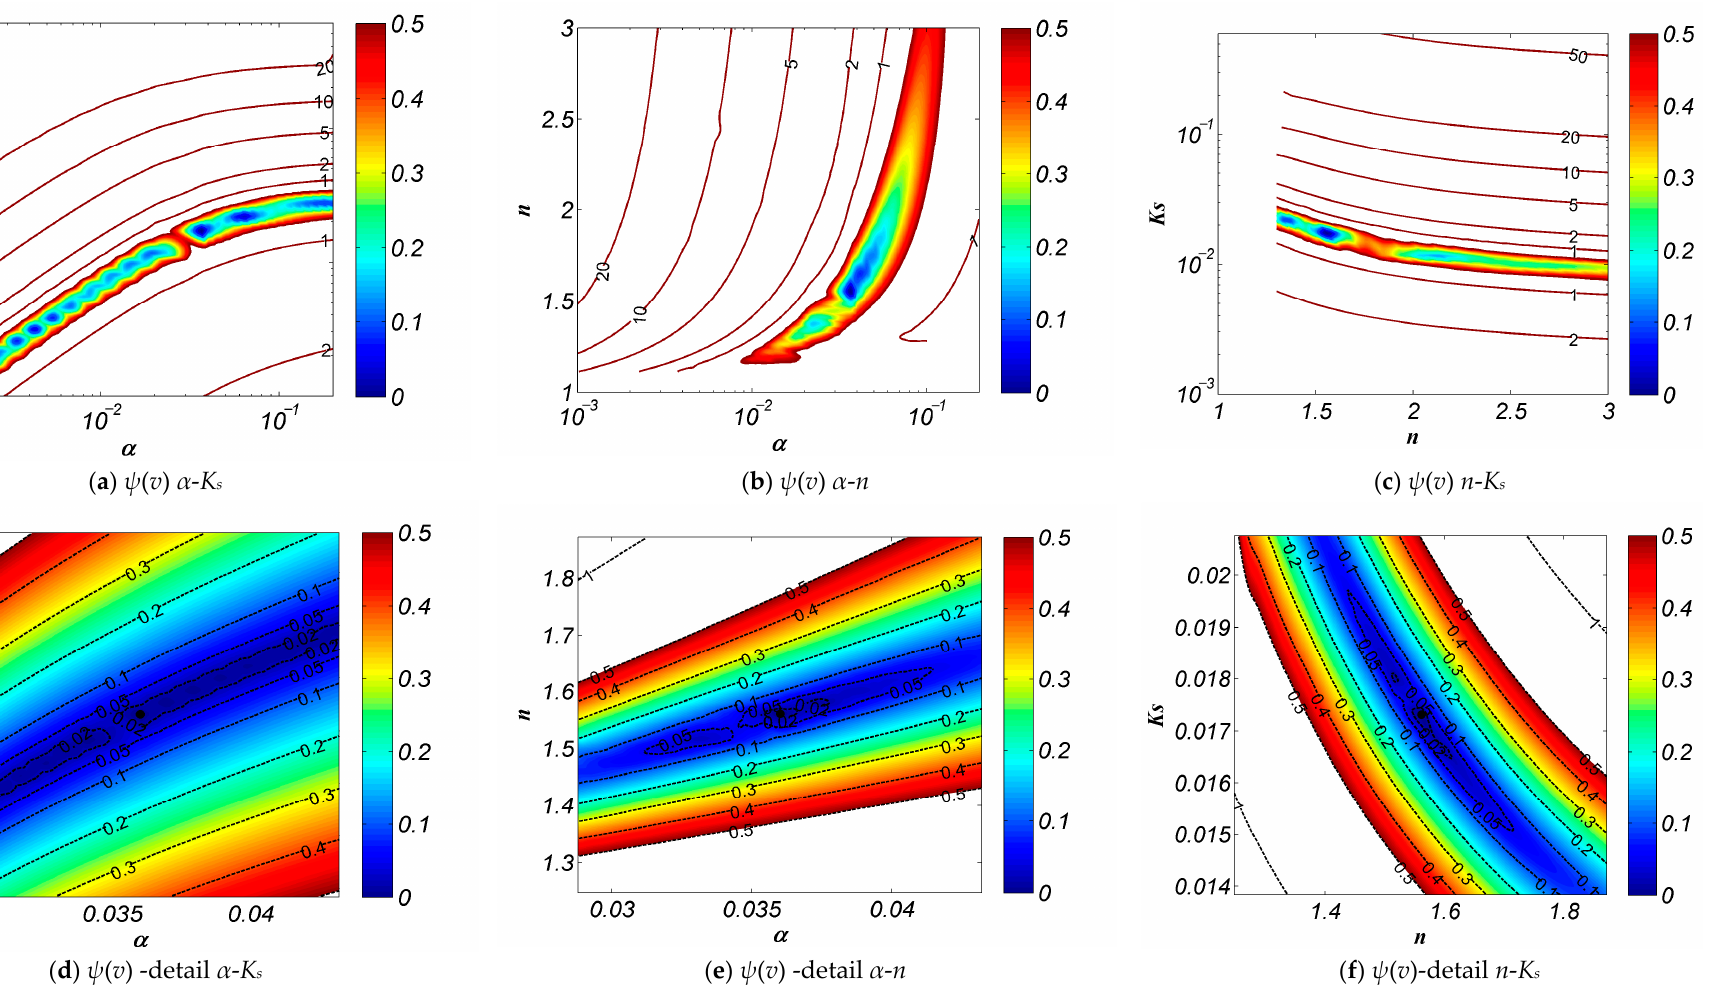
Figure 5. Contours of the objective function ψ ( v ) of loam with θ initial as 40% effective saturation. The hydraulic parameters of loam: K s = 0.0173 cm·min − 1 ; n = 1.56; α = 0.036 cm − 1 ; θ s = 0.43 cm 3 ·cm − 3 ; θ r = 0.078 cm 3 ·cm − 3 . Results are plotted in the parameter planes of ( a , d ) α - K s , ( b , e ) α - n , and ( c , f ) n - K s . The global scale is depicted in ( a – c ), while the local scale near the minimum is depicted in ( d – f ).